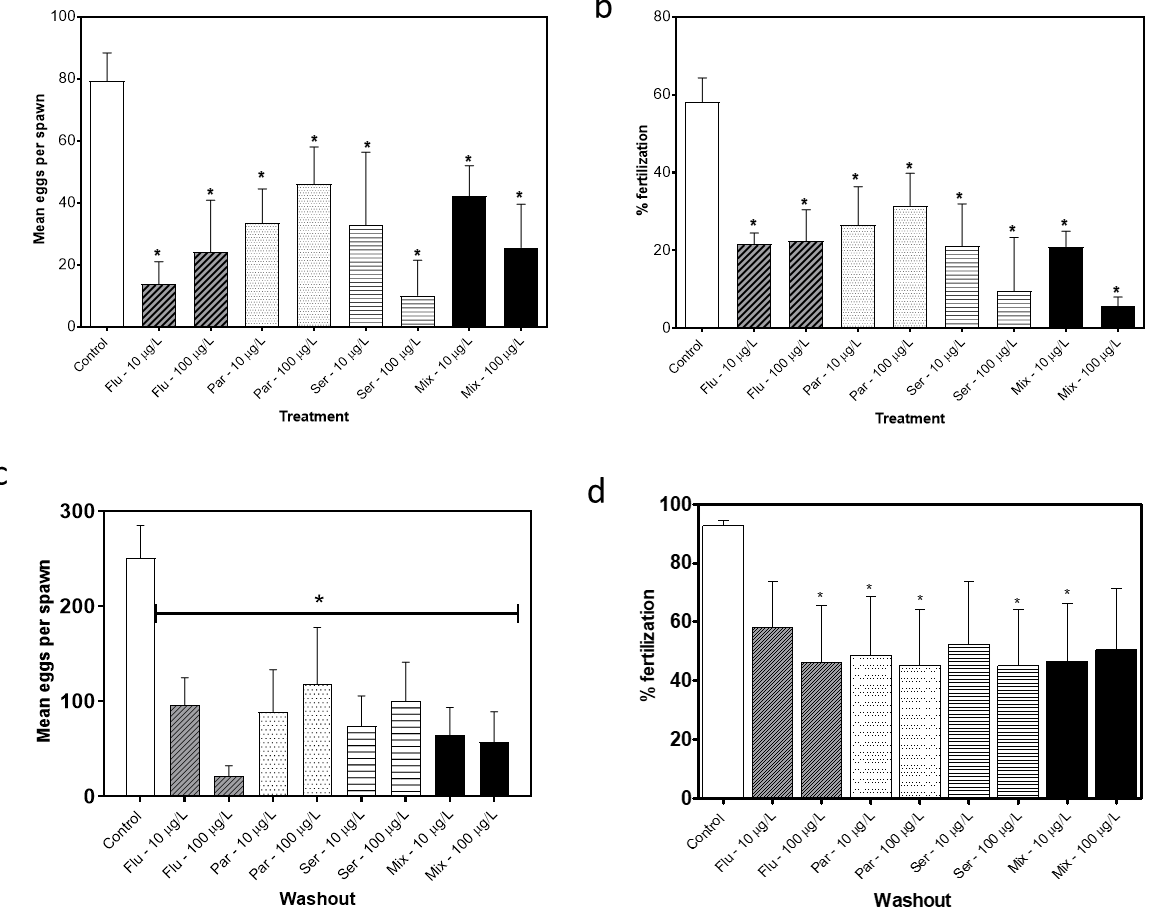
Figure 5. Mean number of eggs generated per single pair cross (all eggs regardless of viability) over a 3 week period for all fish in the treatment (Flu — Fluoxetine, Par — Paroxetine, Ser — Sertraline, Mix — mixture of all three compounds) and control groups ( a ) and following a 2 week washout period ( c ). Percent fertilization of clutches for the treatment ( b ) and washout groups ( d ). Statistical significance with respect to the control fish group was determined using a one-way ANOVA followed by a Dunnett’s multiple compariso ns test (* p < 0.05).